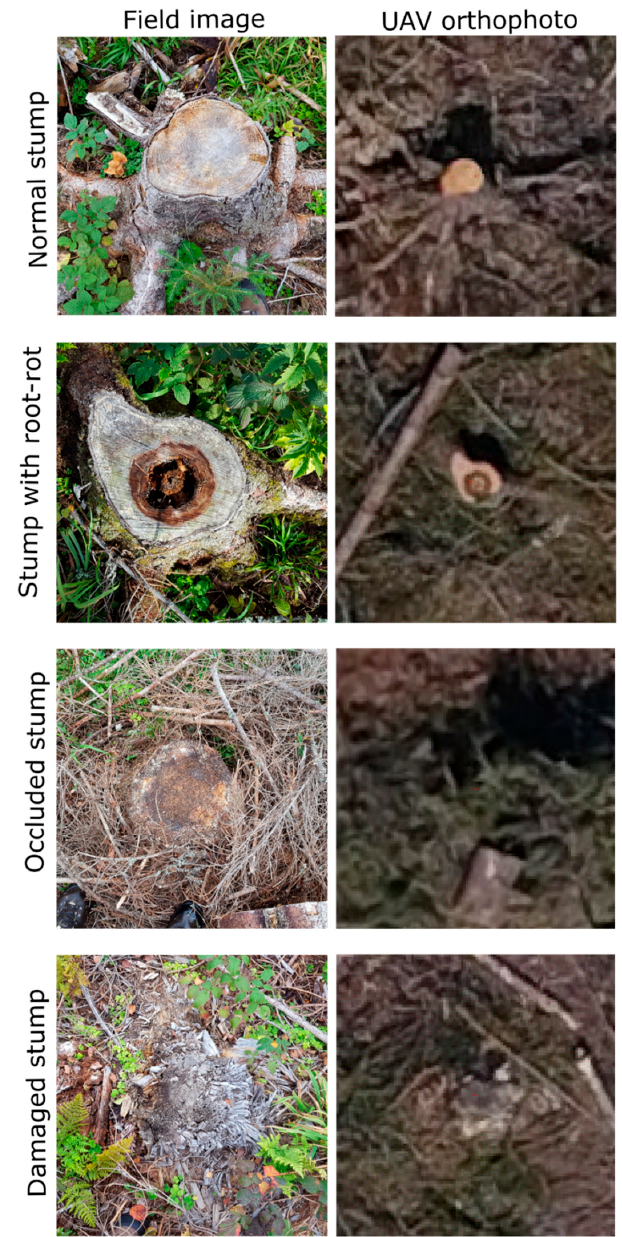
Figure 3. Different classes used for the field-based classification of the tree-stumps. Note that the covered tree-stump was visible only after the manual removal of the logging residuals over it.